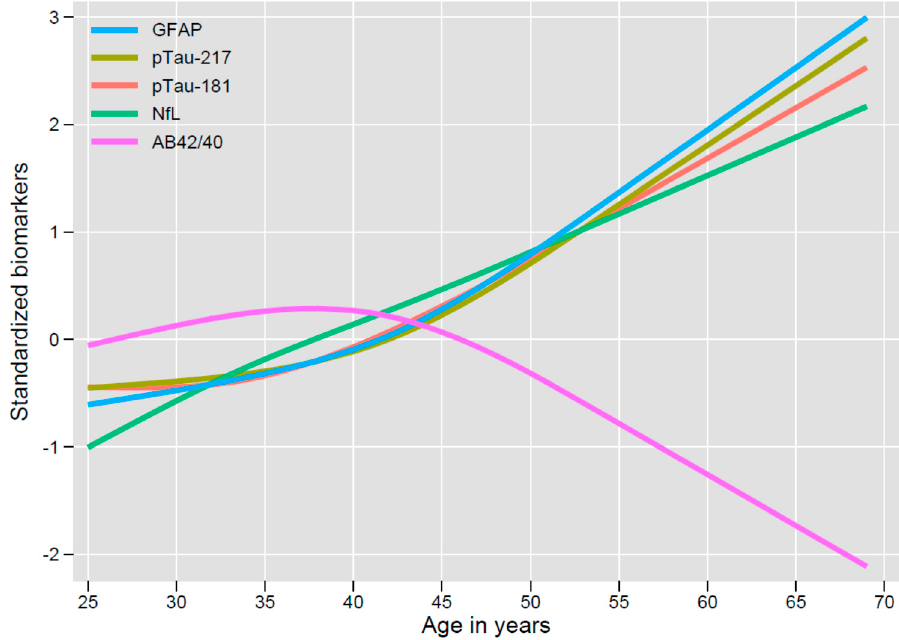
Figure 1. Shown are the predictions from linear regressions of each biomarker on age, using restricted cubic splines with 4 knots. Biomarkers were z-transformed to standardize the Y-axis. Robust standard errors were used. F-tests for the association of each biomarker with age was statistically significant (GFAP: F(3, 82) = 14.05, p < 0.0001; p -tau 217: F(3, 82) = 9.91, p < 0.0001; p -tau 181: F(3, 82) = 10.14, p < 0.0001; NfL: F(3, 82) = 34.57, p < 0.0001; A β 42 /A β 40 ratio: F(3, 82) = 4.71, p = 0.0044), but for the A β 42 /A β 40 ratio, this is dependent on the oldest participant; see Supplementary Figures S2–S6. (Abbreviations: A β 42/40 = amyloid β 42/40 ratio, GFAP = glial fibrillary acidic protein, NfL = neurofilament light, p-tau 181 = phosphorylated tau at threonine − 181, p-tau 217 = phosphorylated tau at threonine − 217).